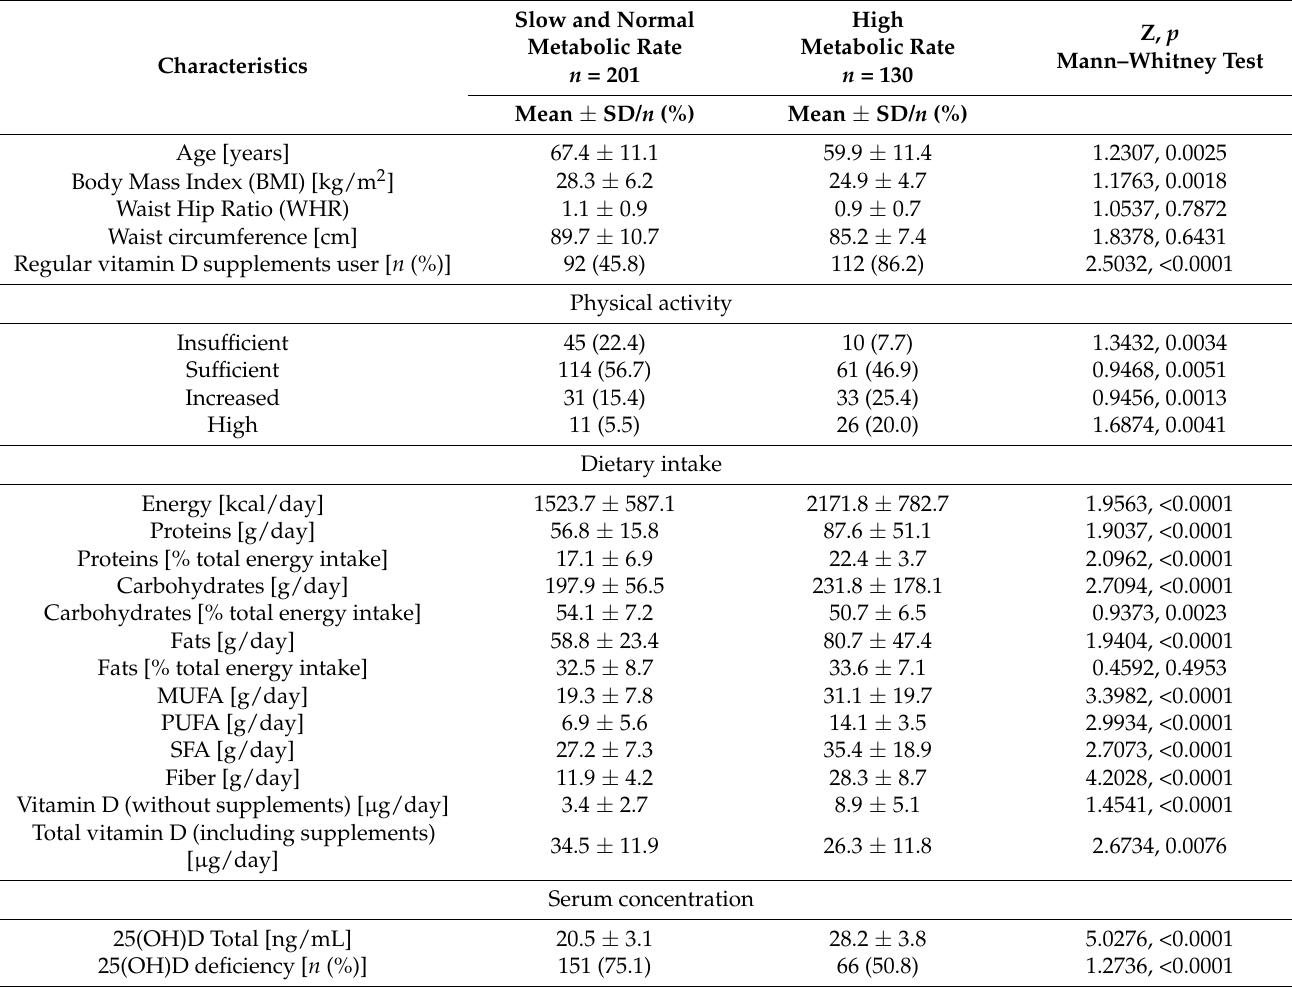
Table 3. Characteristics of the participating women according to the level of metabolic